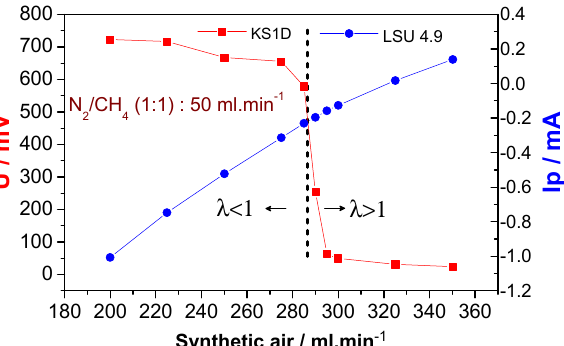
Figure 1. Sensor signals of the KS1D and LSU 4.9 oxygen sensors measured simultaneously in N 2 /CH 4 (1:1) gas flows admixed with increasing flows of synthetic air. The lambda leap at λ = 1 is indicated by a grey dashed